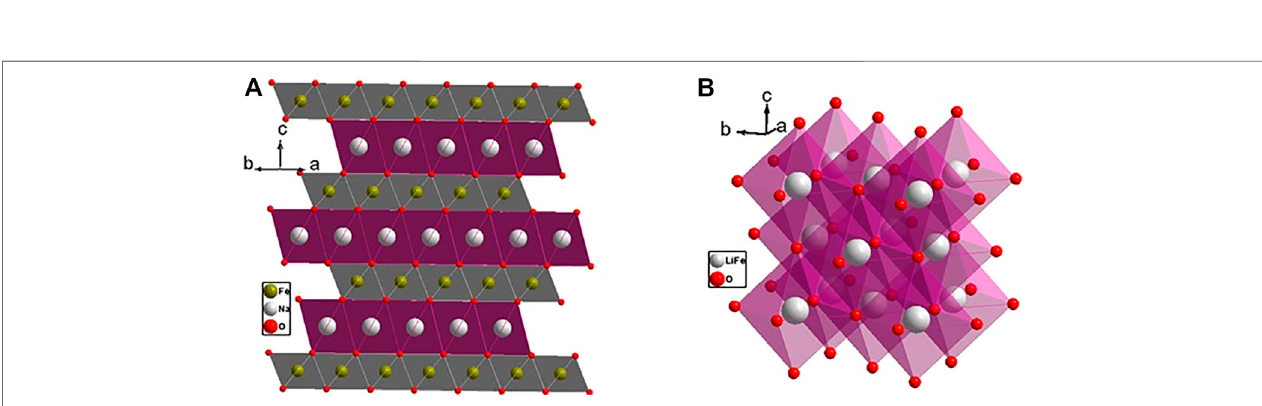
FIGURE 7 | (A) Layered cation-ordered lithium transition metal oxide ( R -3 m space group); (B) cation disordered rocksalt structure ( Fm -3 m space group).